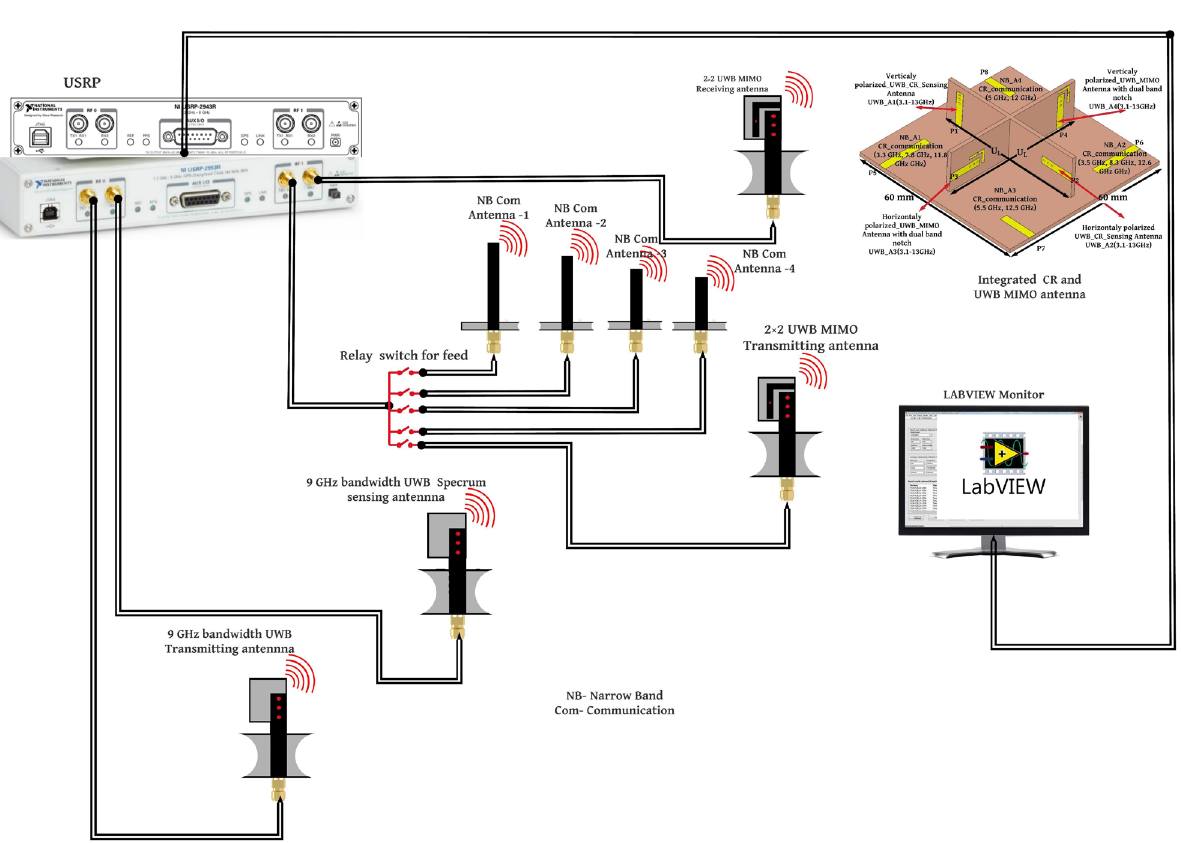
Figure 21. Block diagram of the proposed Hardware